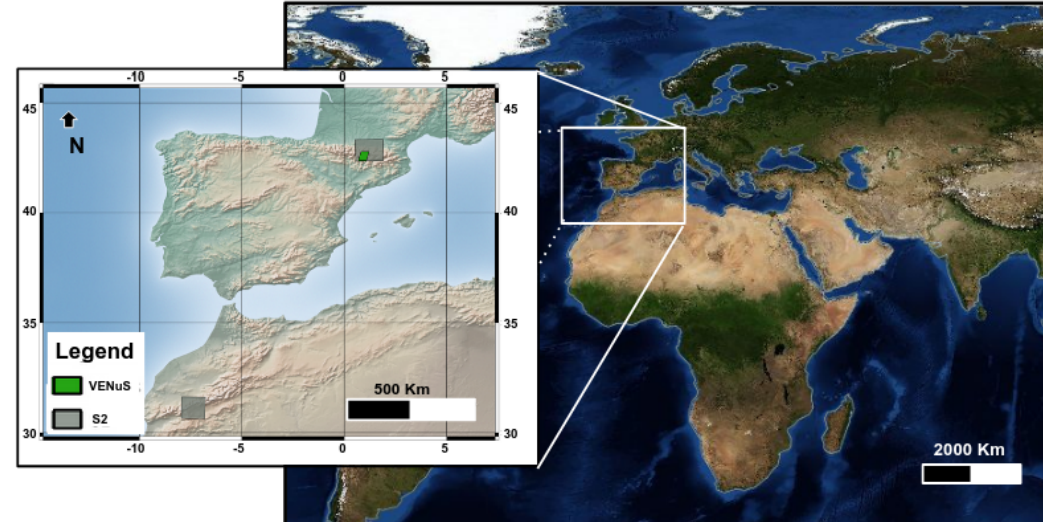
Figure 2. The study areas: coverage of Sentinel-2 (S2) and VEN µ S tiles. The tile located to the south is T29RPQ (S2, High Atlas), the grey one in the north is T31TCH (S2, Pyrenees) and the green one is the VEN µ S tile